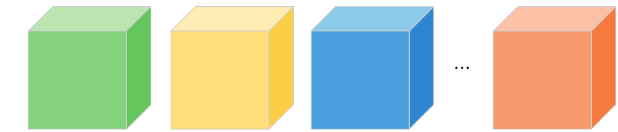
Figure 4: Four-dimensional matrix diagram.